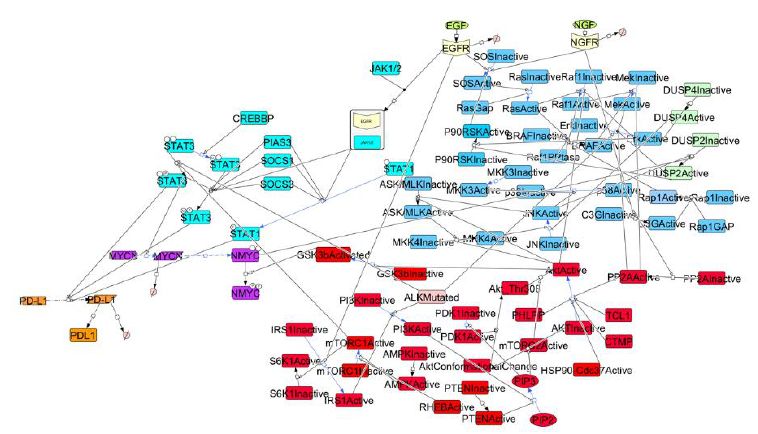
Figure 1. Graphic representation of the pathways considered in the model. Square shape: gene; diamond shape: mRNA; circle shape: simple molecule; square shape with smooth corners: protein; Ø: degraded; blue: MAPK (Mitogen-activated protein kinase) pathway, red: PI3K (phosphoinositide- 3-kinase) / AKT / mTOR (mammalian Target Of Rapamycin) pathway; light blue: JAK (Janus Kinase) / STAT (Signal Transducer and Activator of Transcription) pathway; purple: MYCN transcription; orange: programmed cell death-ligand 1 (PD-L1)